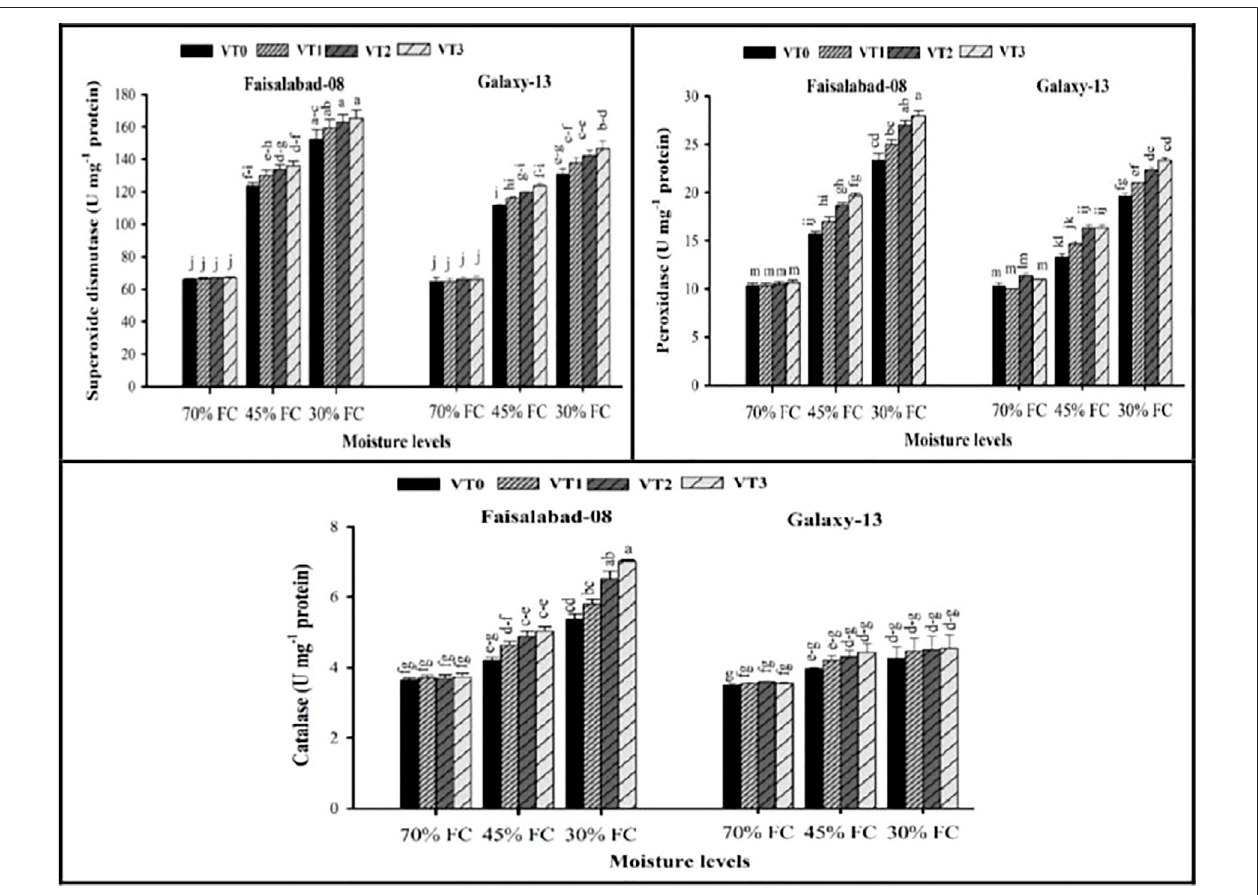
FIGURE 4 | Effect of soil-applied wheat straw vermicompost on superoxide dismutase, peroxidase, and catalase activities of two wheat cultivars under different droughtlevels[70% fi eldcapacity(FC),45%FC,and30%FC].Barswithdifferentalphabeticallettersdiffersigni fi cantlyat5%probability,accordingtoTukey ’ sHSDtest. VT 0 , control; VT 1 , 4 t ha − 1 ; VT 2 , 6 t ha − 1 ; and VT 3 8 t ha − 1